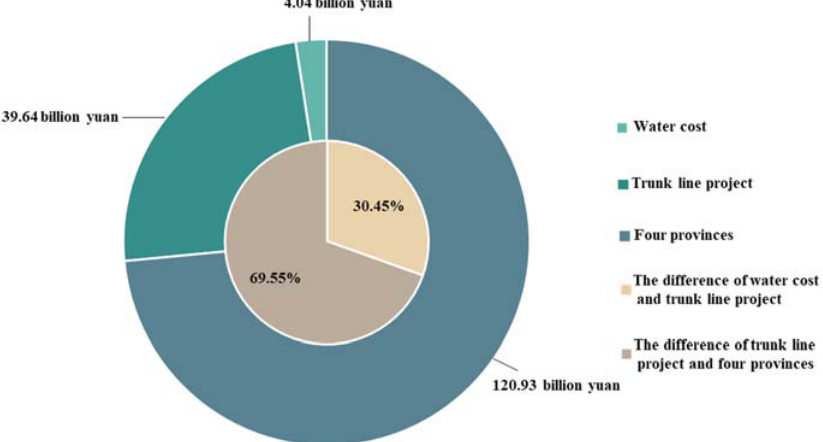
Figure 7. Total water cost, total water value of the trunk line project, and four provinces of the SNWD.